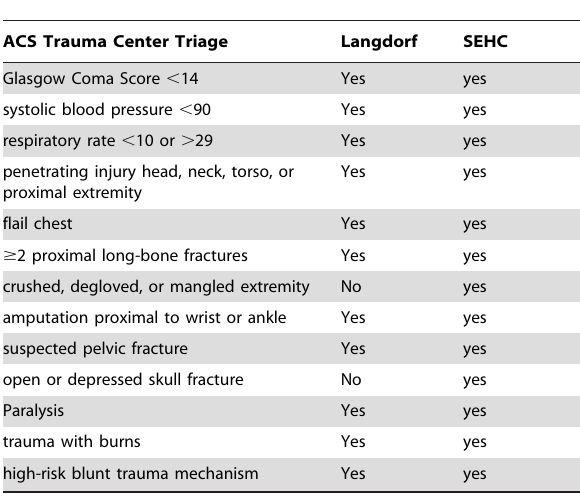
Table 3. Trauma Activation Patients inclusion